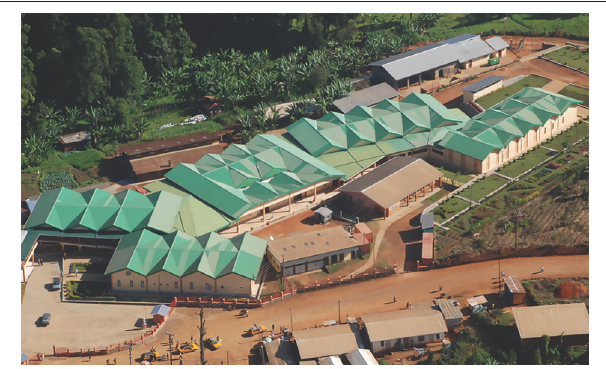
FIGURE 1 | Overview of the CC: the green roofs are the Cardiac Center [Internal archive, IRCCS Policlinico San Donato, San Donato M.se, (Mi), Italy].